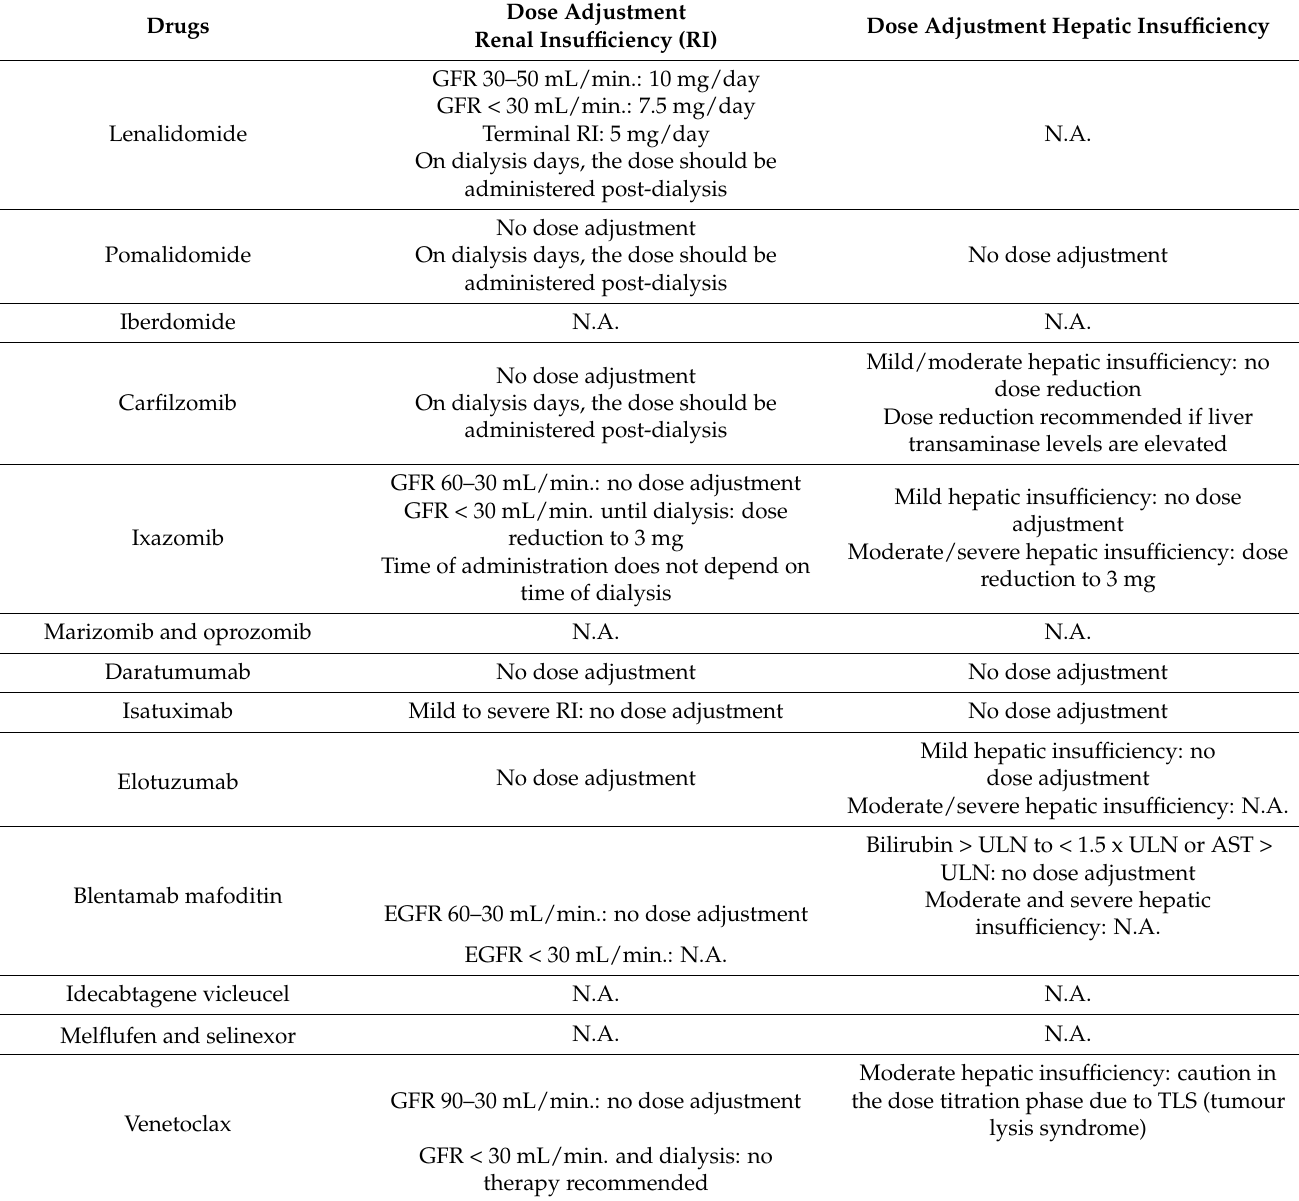
Table 1. New drugs in the treatment of patients with RRMM and renal and hepatic insufficiency. Dose Adjustment Drugs Renal Insufficiency